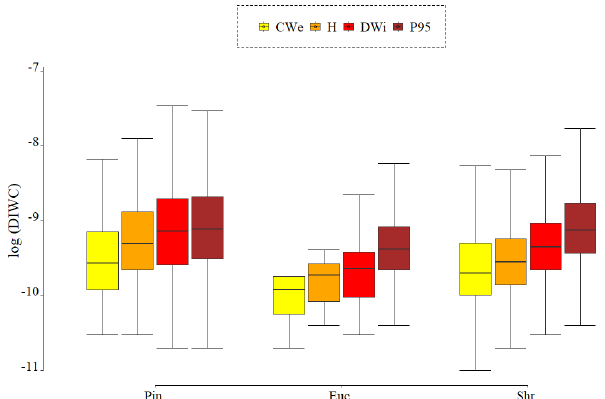
Figure F1. Natural logarithm of the normalized wildfire connec- tivity (DIWC) of patches with FLI above 4000kWm − 1 , estimated from fire spread simulations with historical (CWe, H, DWi) and ex- treme ( P 95 ) weather conditions. Pin.: pine forest; Euc.: eucalypt plantations; Shr.: